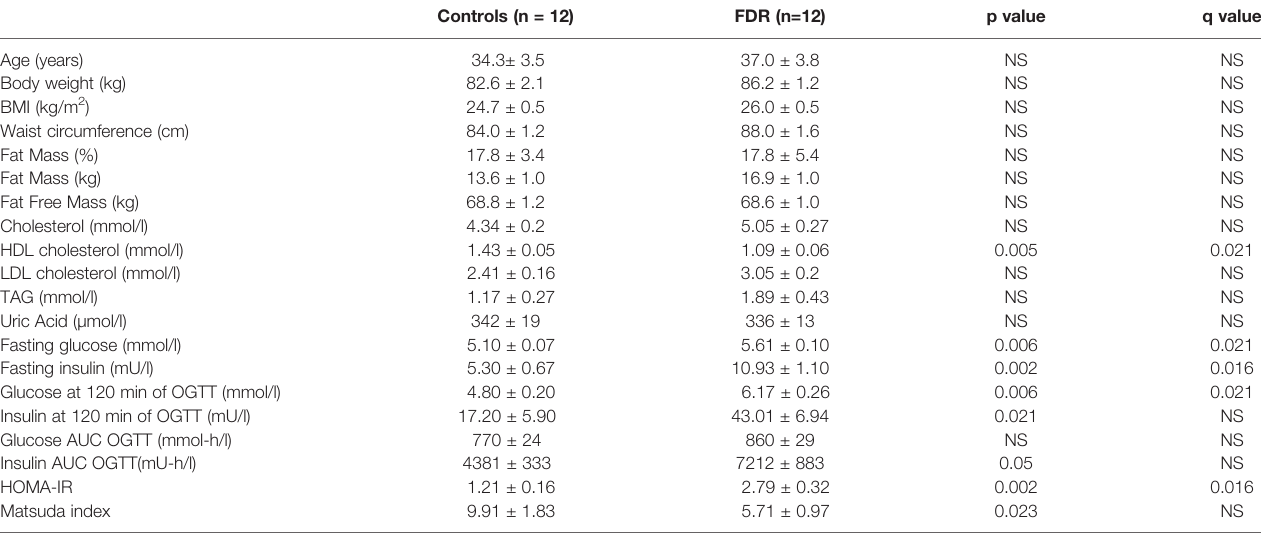
TABLE 1 | Anthropometric and biochemical characteristics of the